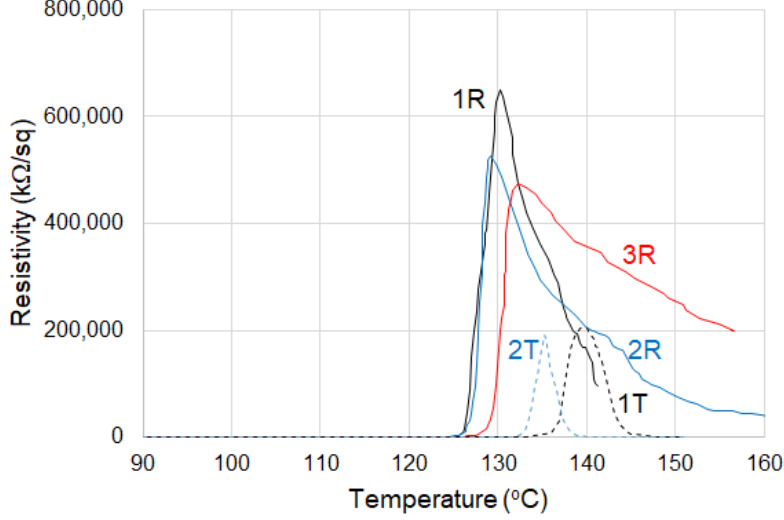
Figure 8. Resistivity vs. temperature for (CB + Gr)/HD samples on repeated temperature cycles, heating portions: 1T, 2T — thermoplastic (D = 0 kGy) at first and second cycle, respectively; 1R, 2R, 3R — crosslinked (D = 150 kGy), cycles 1, 2 and 3, respectively.